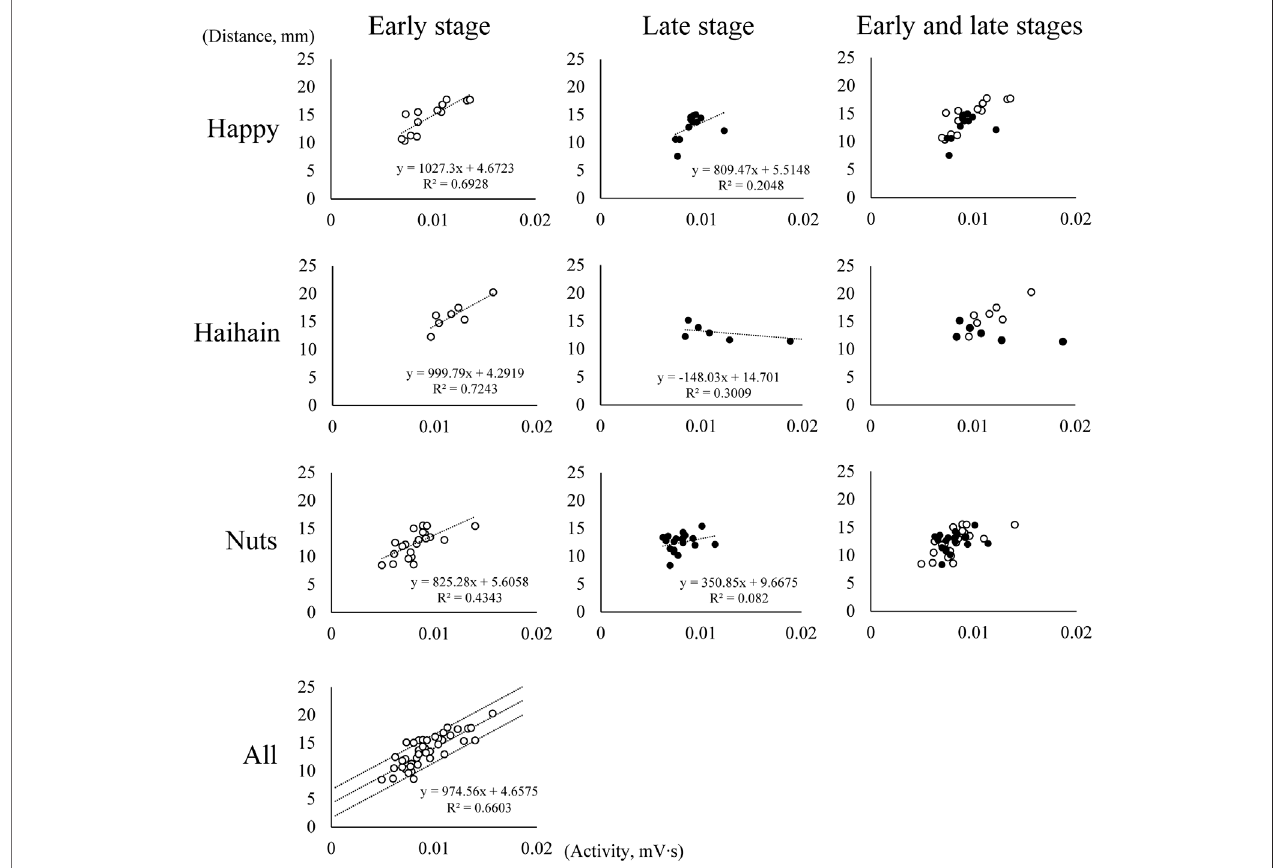
FIGURE 4 | Relationship between suprahyoid electromyographic activity and maximum vertical jaw distance (jaw gape) in one participant. Each graph shows the relationship between suprahyoid activity and jaw gape in one masticatory cycle. The number of masticatory cycles in the masticatory duration was 26 during Happy mastication,14duringHaihainmastication,and41duringNutsmasticationwithsigni fi cantpositivecorrelationamongtheminalltestfoodsintheearlystage.Dottedlines indicate the regression line and 95% conference intervals obtained (All).